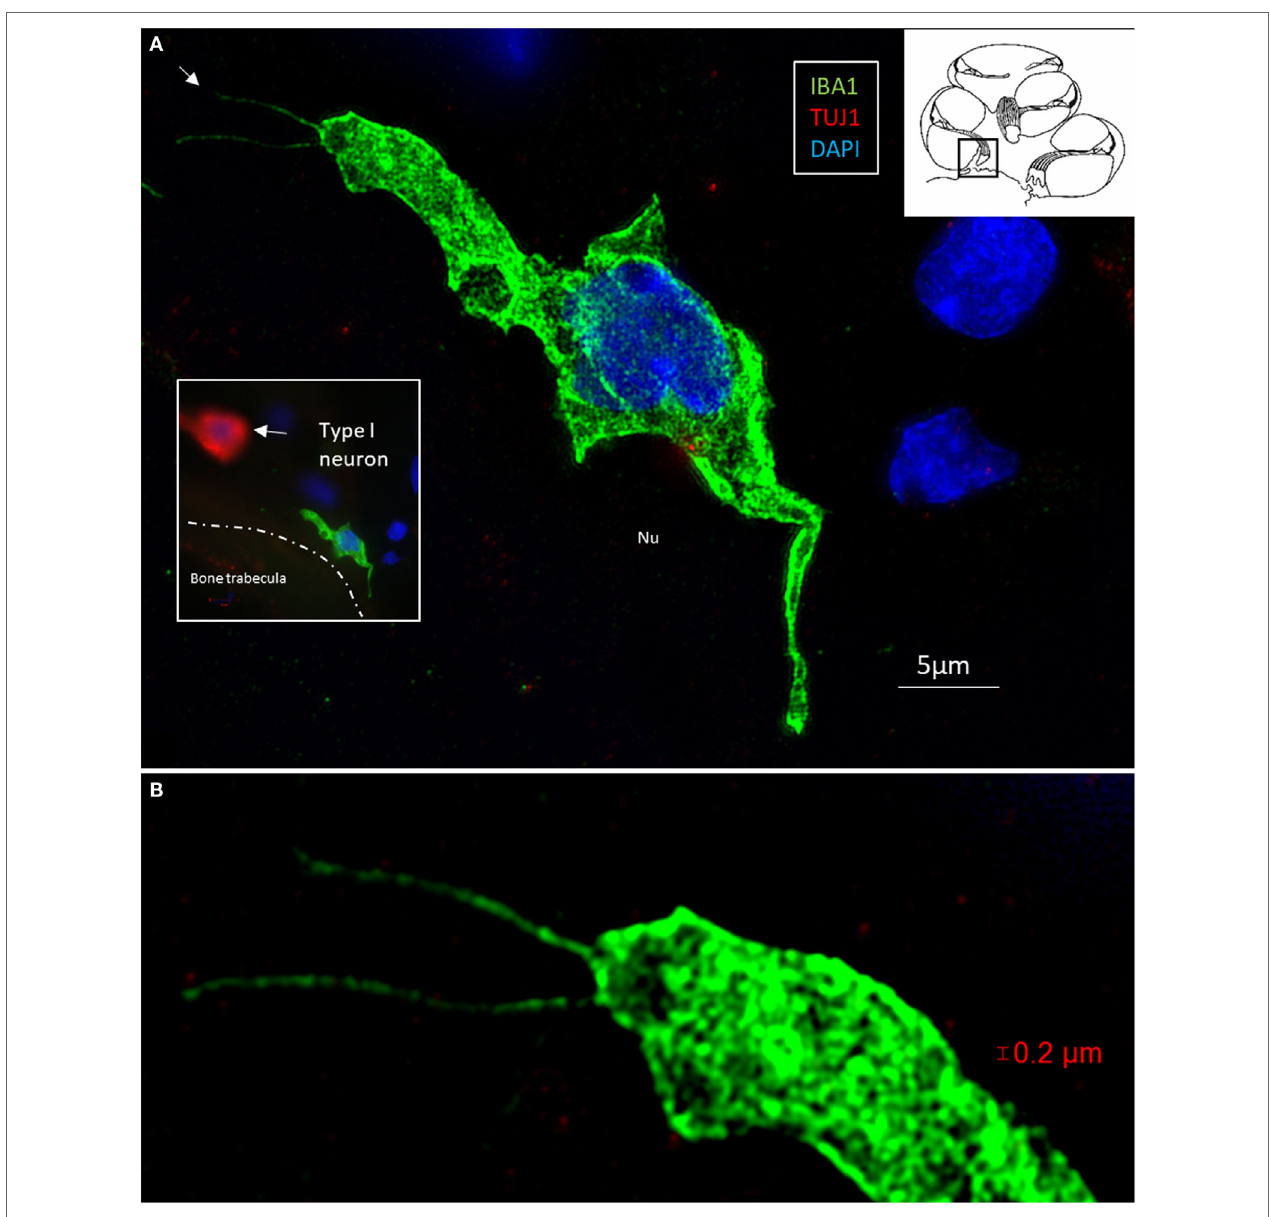
FigUre 6 | (a) Surveilling macrophages with projecting “antennae” exist around the human type I cells. (a) SR-SIM (maximum intensity projection) of an ionized calcium-binding adaptor molecule 1 (IBA1)-positive macrophage at the bone trabecula in Rosenthal canal of the first turn of the cochlea. Inset shows relationship to a TUJ1-positive neuron. (b) Higher magnification shows “horn”-like projections (arrow). Cytoplasmic vesicles as well as its nucleus contain IBA1